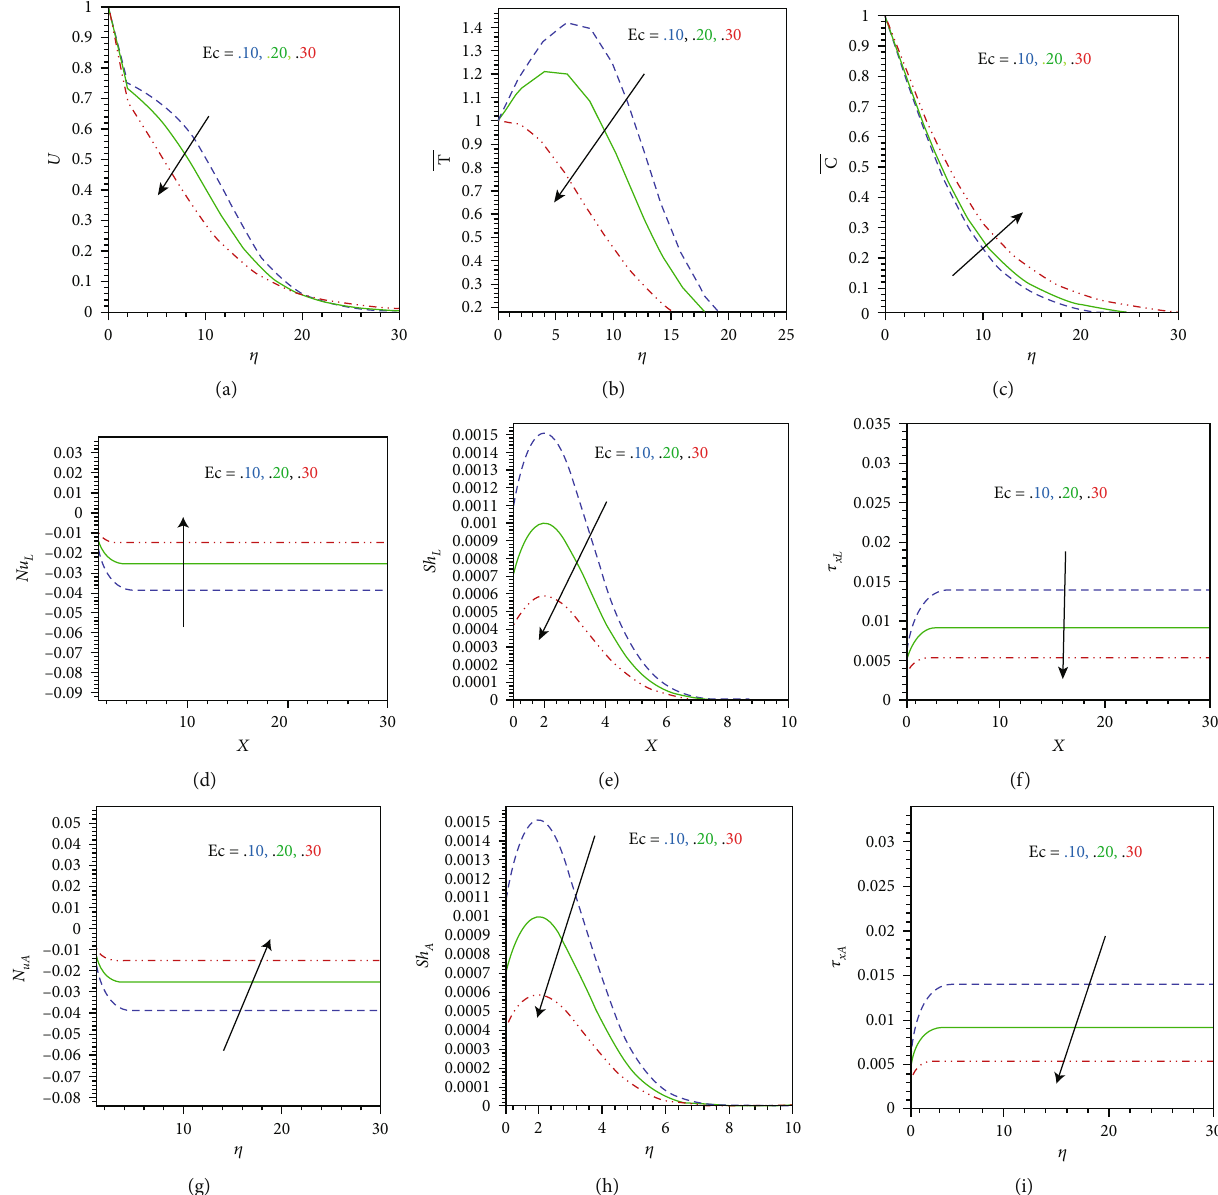
Figure 10: In fl uence of Eckert number on (a) fl ow, (b) thermal, (c) material fi elds, (d) Nu with M = 9 : 5 , Gr = 3 : 5 , Gm = 4 : 5 , Pr = 1 , Sc = 0 : 22 , N = 1 , R = 1 , and H = 0 : 3 .